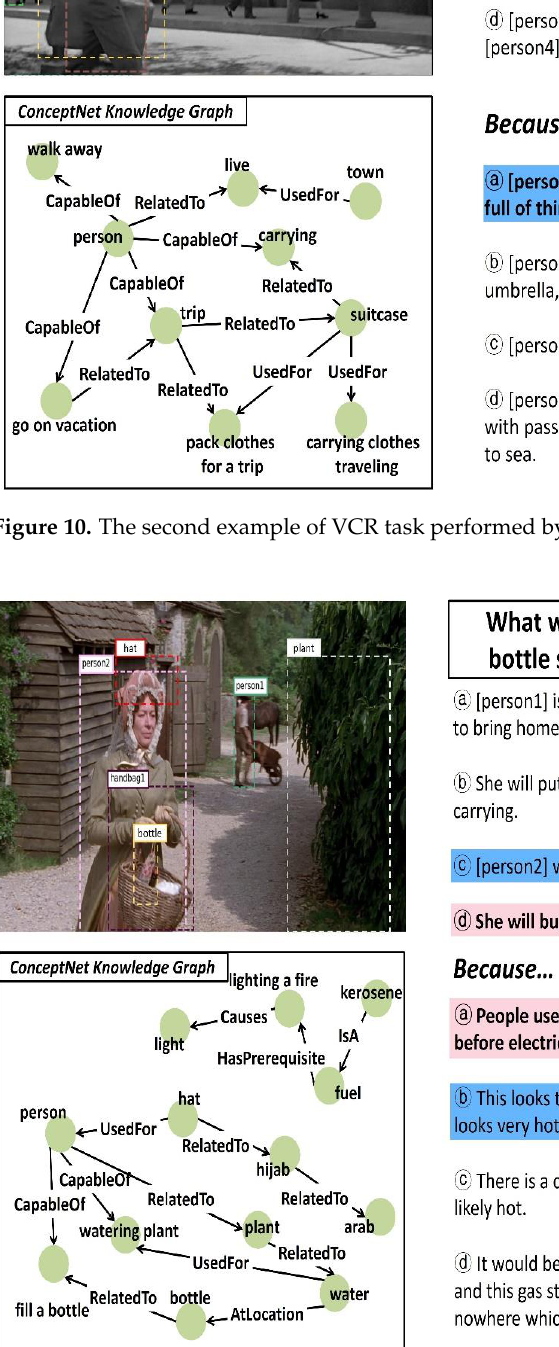
Figure 11. The third example of VCR task performed by the proposed model.